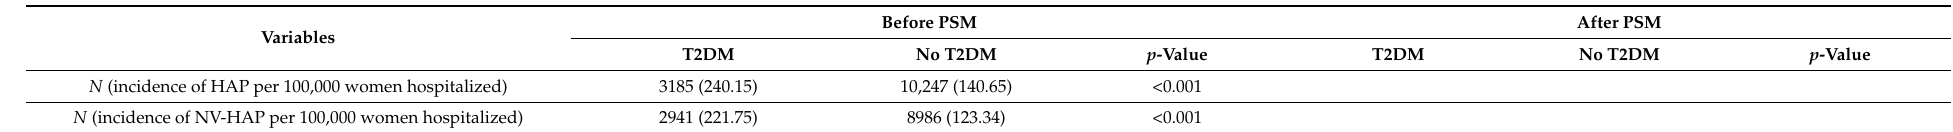
Table 2. Distribution of study covariates and hospital outcomes of women with and without T2DM who developed hospital-acquired pneumonia (HAP) in Spain (2016–2019), before and after propensity score matching